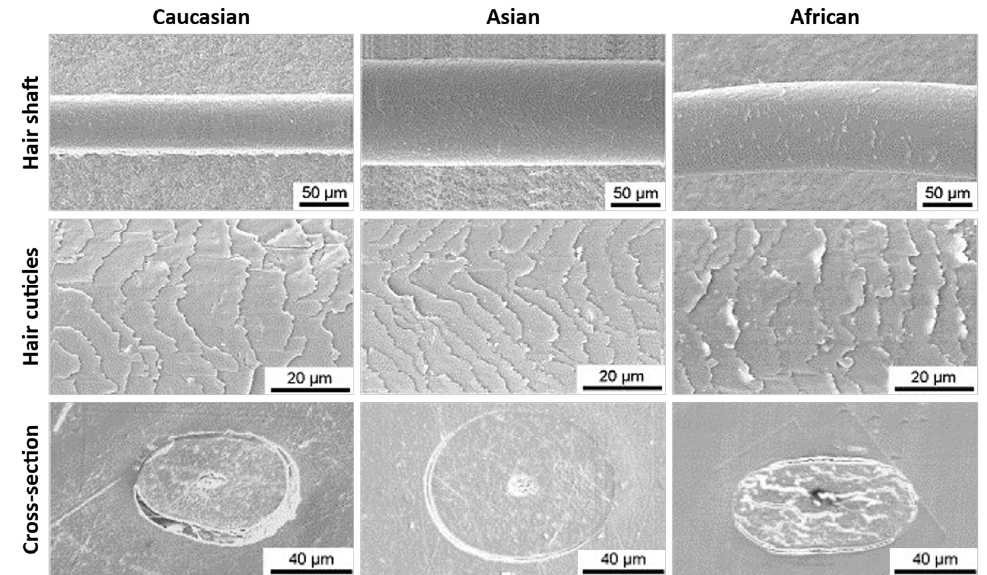
Figure 4. Comparison of hair fibers surface and cross ‐ section from Caucasian, Asian and African people by SEM. Adapted from reference [23] with permission from Elsevier.